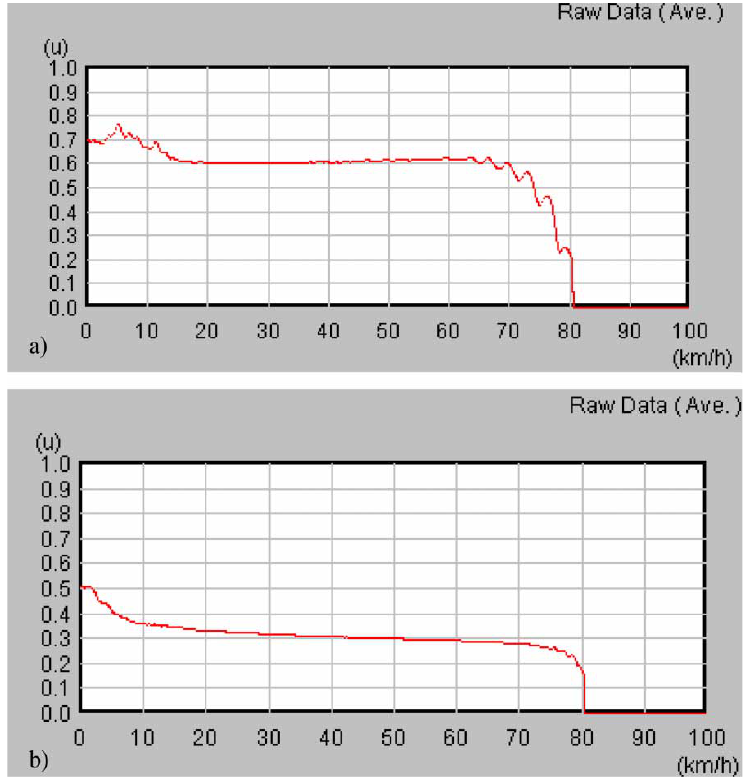
Fig. 5. Measured friction coefficient versus slip speed for samples: (a) exposed aggregate concrete 1; (b) smooth concrete 1